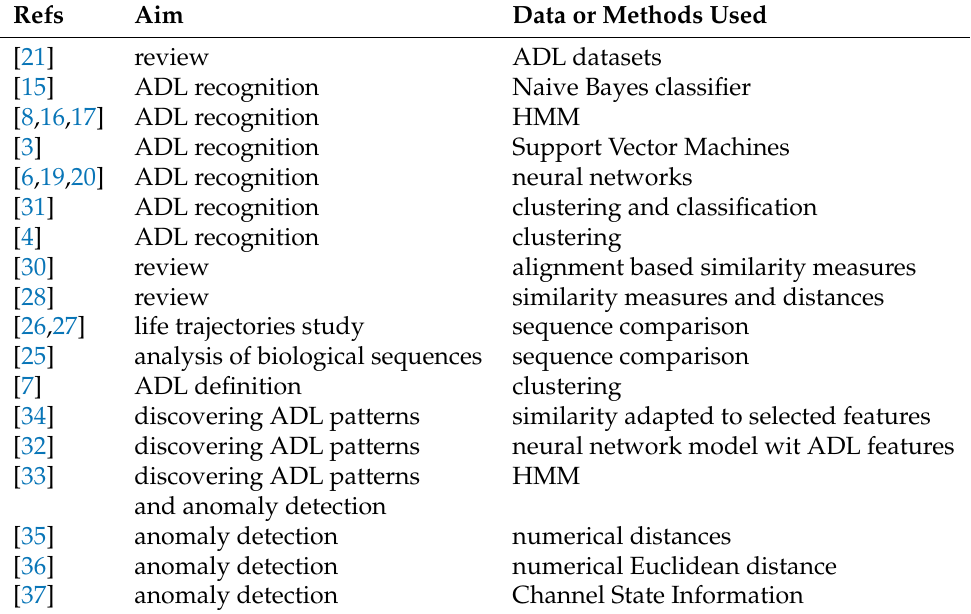
Table 1. Studies related to our